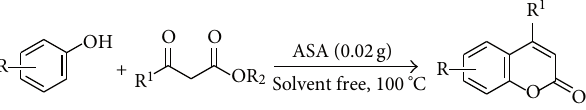
S 1: ASA catalyzed synthesis of coumarins under solvent-free